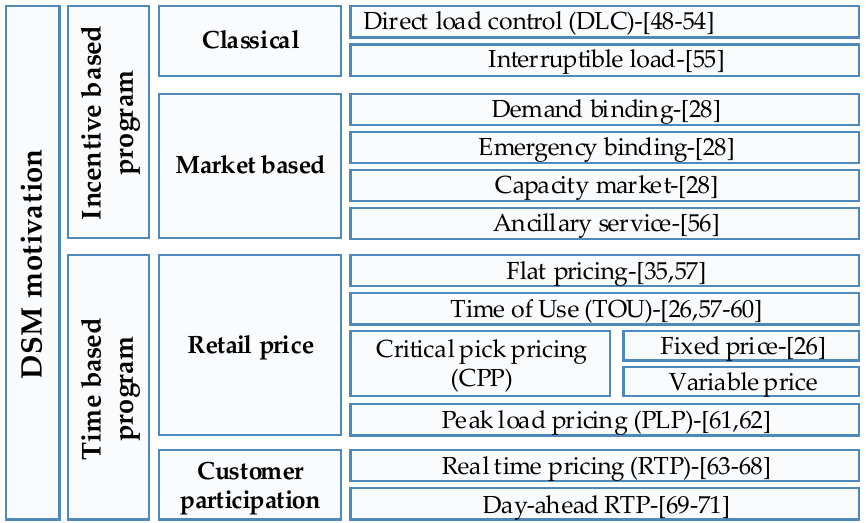
Figure 1. Breakdown of electricity consumption in the US (2015) [43].